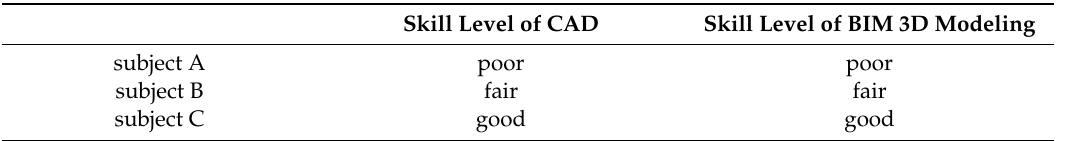
Table 3. Skill level of subjects.